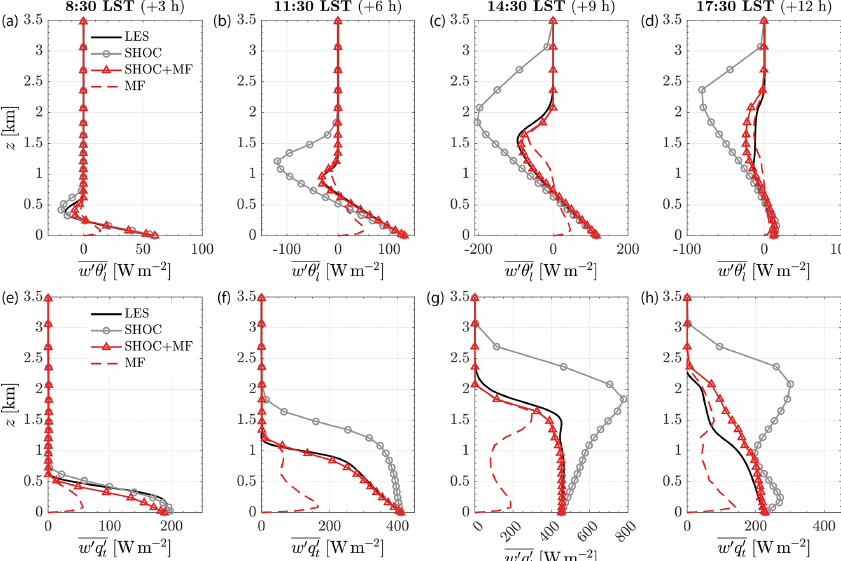
Figure 5. Vertical profiles of turbulent fluxes of (a–d) liquid water potential temperature and (e–h) total water mixing ratio for LES (solid black line), SHOC (solid grey line), SHOC + MF (solid red line), and MF (dashed red line) for the ARM shallow cumulus case. The label “HH:MMLST ( + X h)” shows the local standard times (LST) and the hour mark relative to the start of the simulation. The profiles correspond to hourly averages around the hour marked on each column (HH:MMLST ±